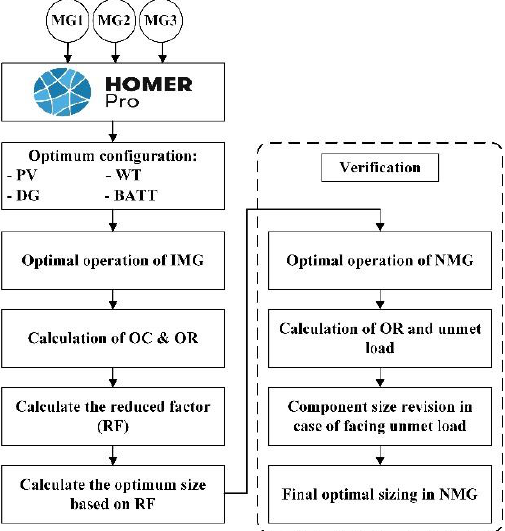
Figure 2. Proposed algorithm of NMG optimal sizing.